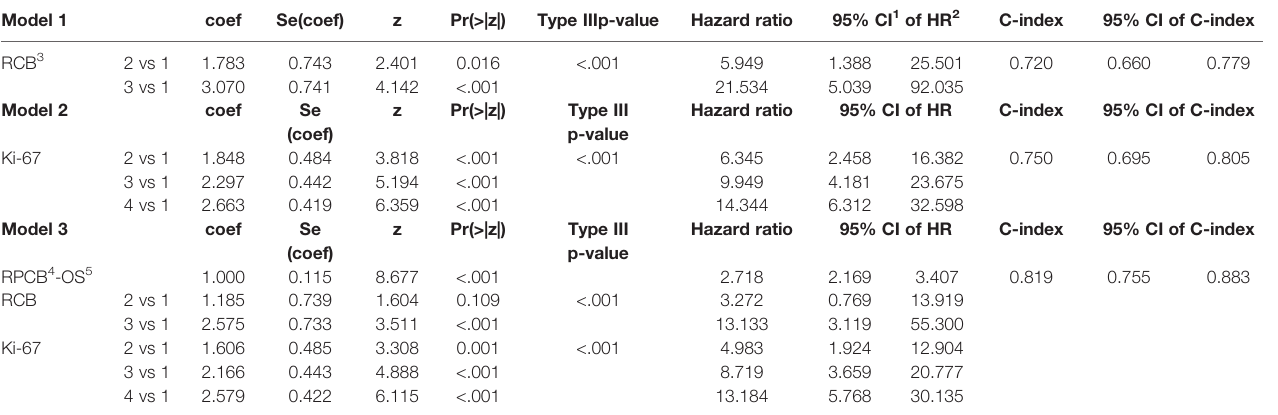
TABLE 2 | Overall survival prediction according to RCB class, Ki-67 and RPCB model. Model